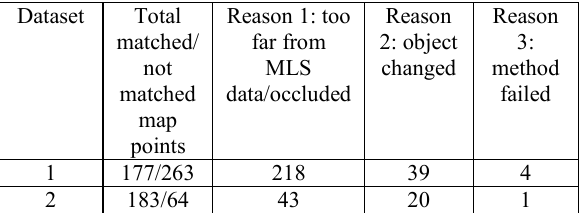
Figure 11. Several detected changes between map and MLS data in dataset 2, of which 1 (cyan box) missed the match because of having too few points in the